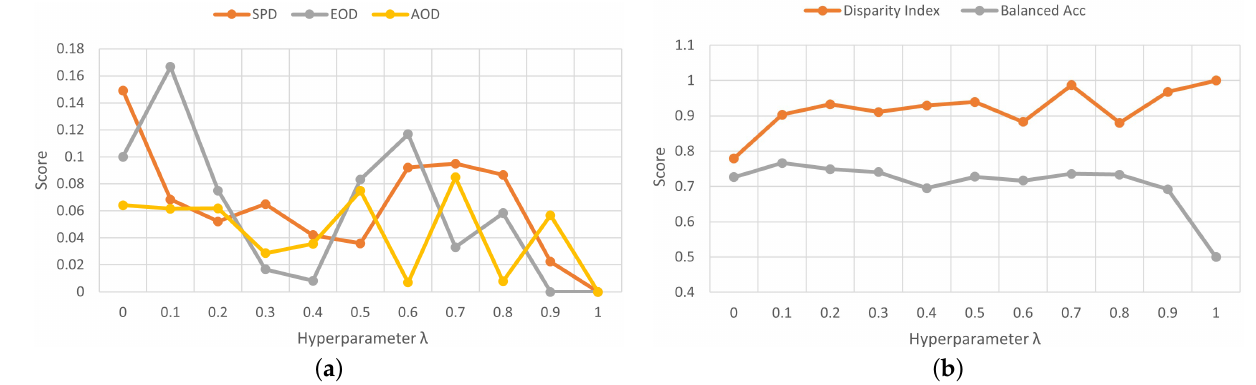
Figure 6. Fairness scores and accuracies for different values of λ : ( a ) SPD, EOD and AOD scores Vs λ ( b ) DI scores and Accuracies Vs λ